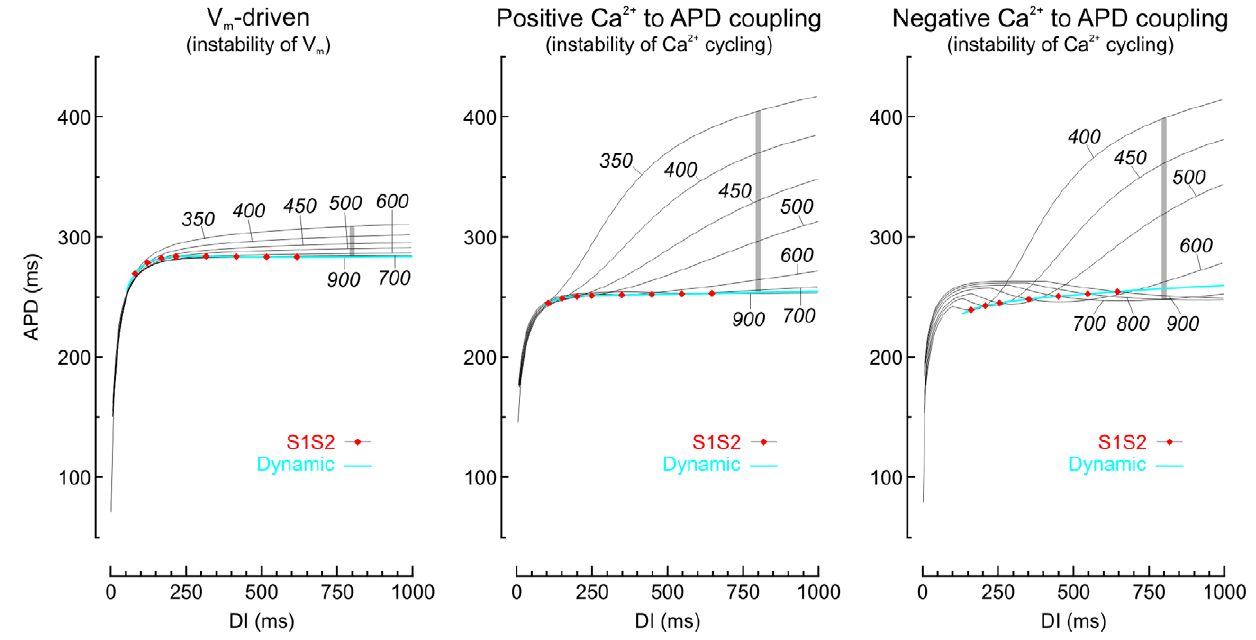
Figure 2. Dynamic and S1S2 restitution curves in the three model versions. Each panel represents the dynamic restitution curve, i.e., steady-state APD vs. DI (blue) and several S1S2 restitution curves (labels indicate BCL, i.e., the S1S1 pacing cycle length). For each S1S2 restitution curve, a broad range of S1S2 intervals were explored, yielding DIs from 0 to 1000 ms. The intersections of the S1S2 restitution curves with the dynamic restitution curve are marked with red diamonds. The vertical gray bars denote memory amplitude at DI=800 ms.